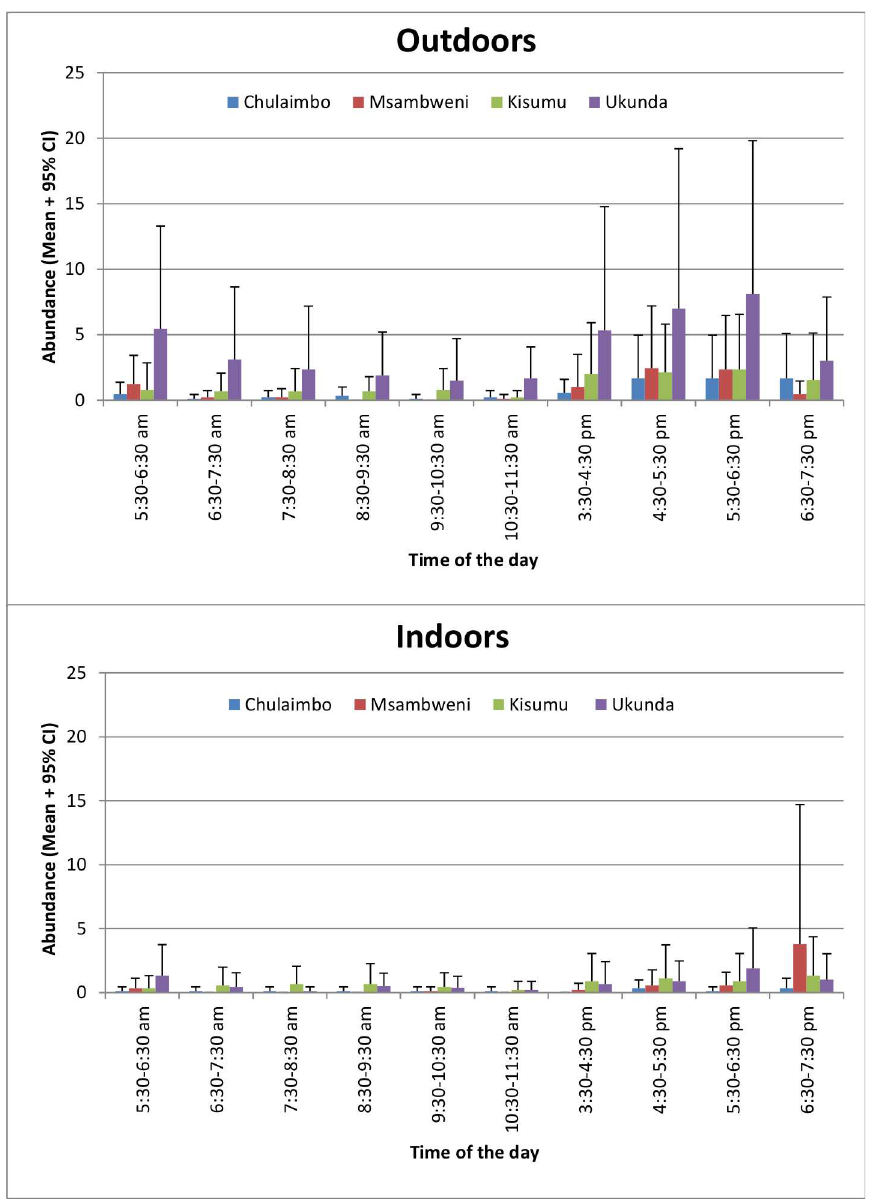
Fig 2. Mean numbers + 95% confidence interval (CI) of Aedes aegypti mosquitoes collected hourly by human landing catches.